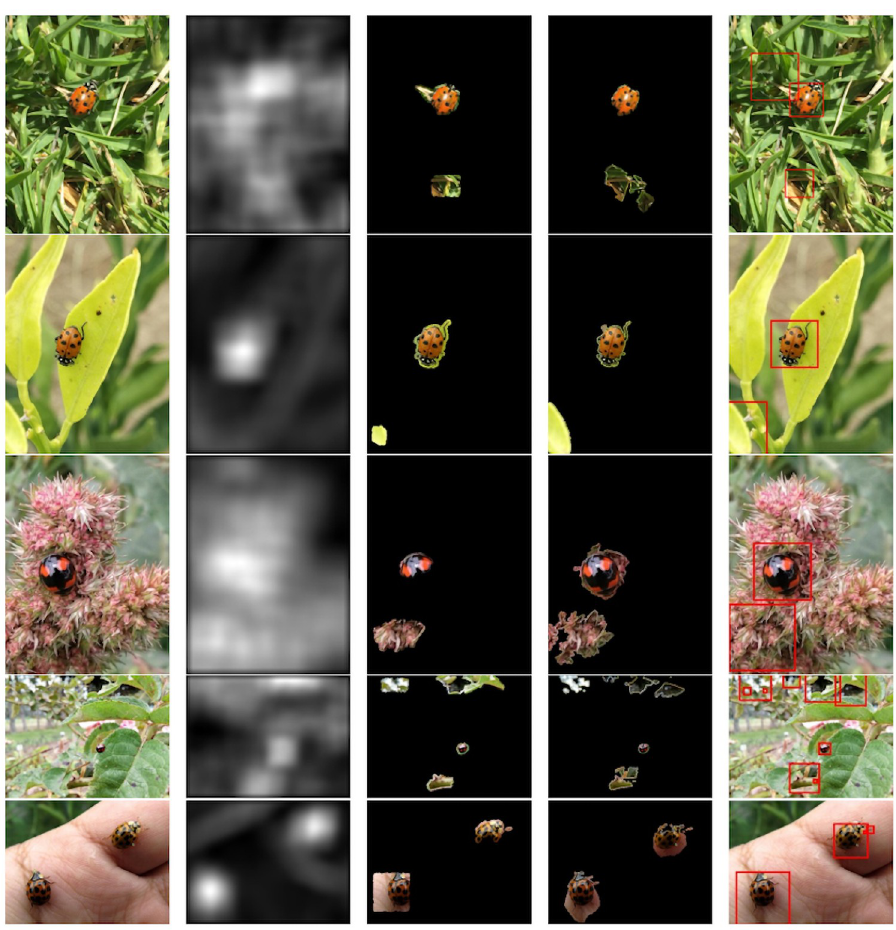
Fig 5. Successful performance examples of the image processing module (first stage of the proposed detector) in different environments. From left to right, original image, saliency map, SLIC superpixels segmentation, Chan-Vese active contour, and final bounding boxes